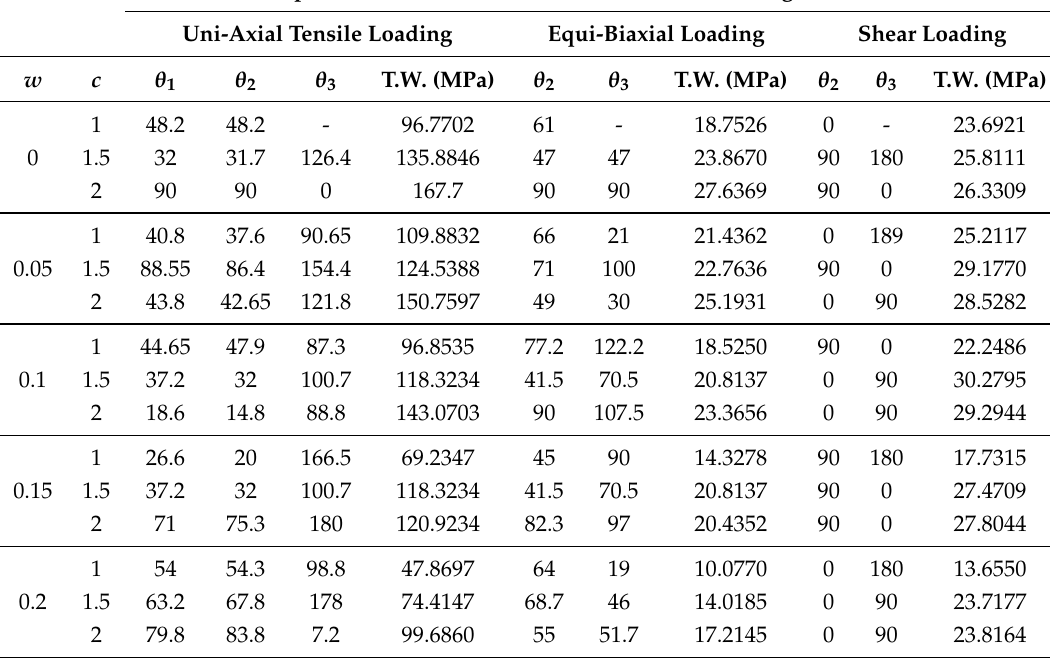
Table 9. The optimal values of design variables in different values of bluntness w and aspect ratio of rectangular cutout c .